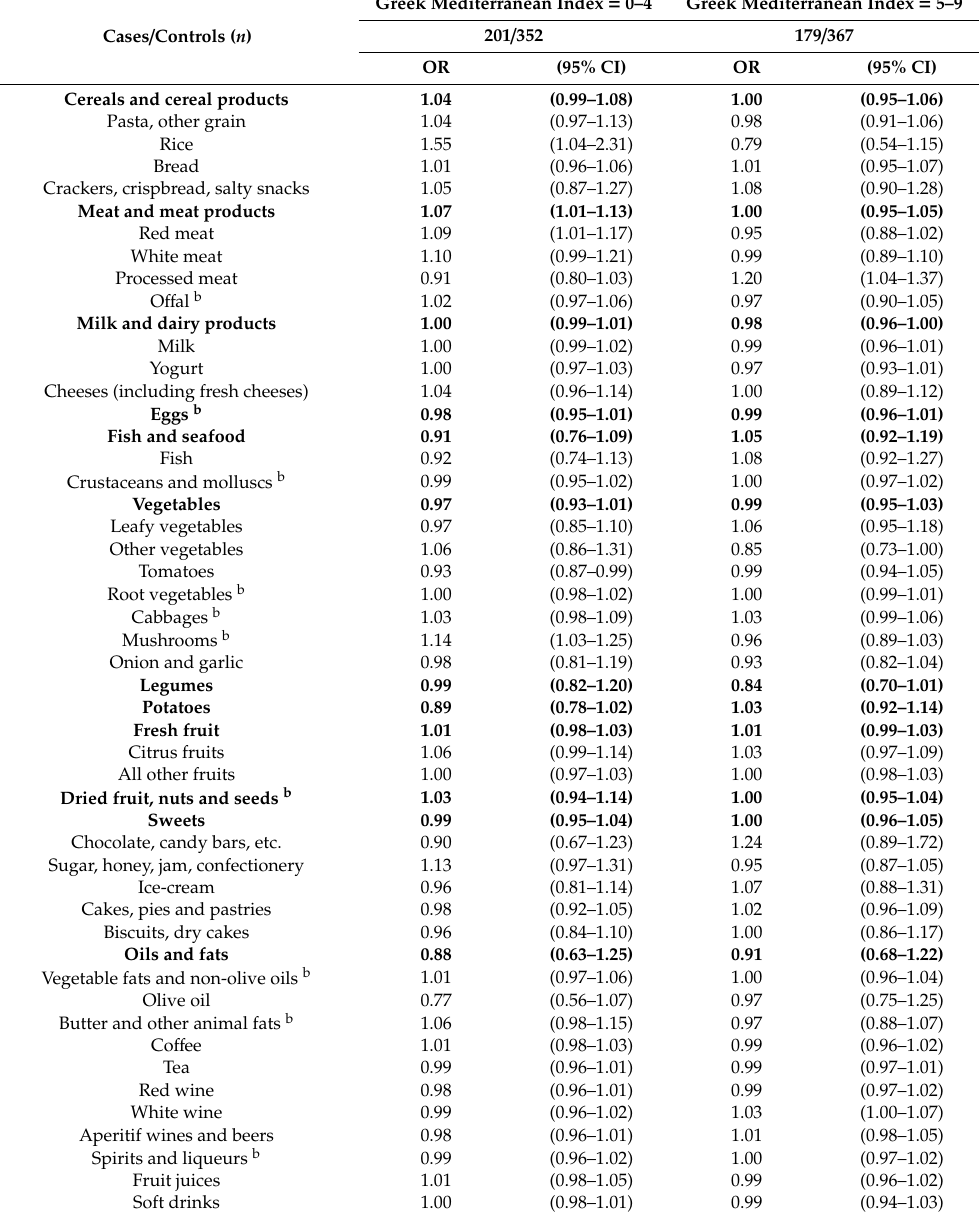
Table 5. Overall adjusted a odds ratios (OR) and 95% confidence intervals (CI) for developing cutaneous malignant melanoma associated to 10-g increments of daily intake (residual of regression on energy) according to adherence to the Mediterranean